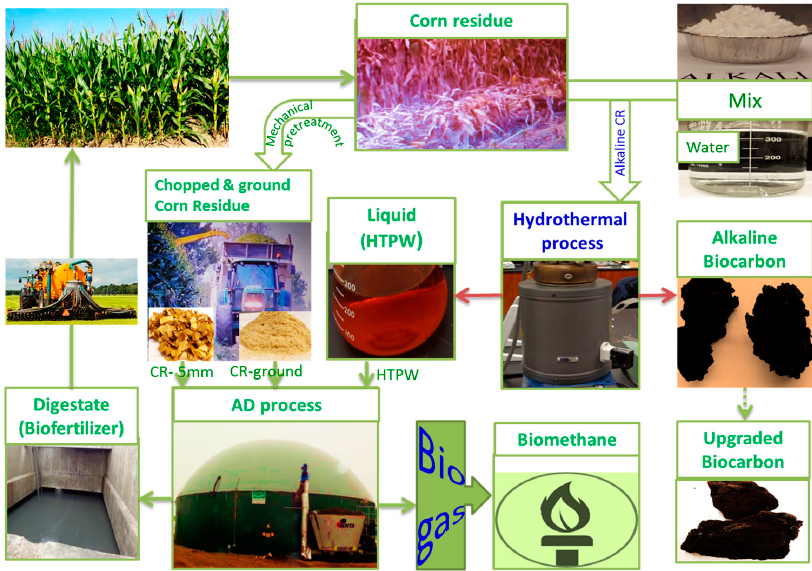
Figure 1. Conceptual framework of the corn residue and its alkaline hydrothermal hybrid bioenergy conversion processes in the resource recovery concept. conversion processes in the resource recovery